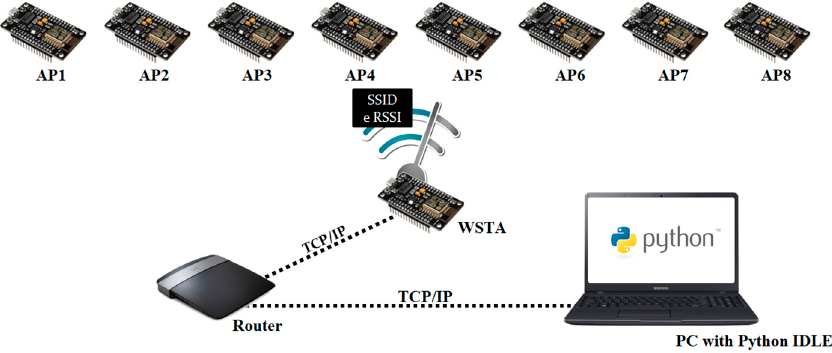
Figure 2. Connection diagram of the elements that make up the localization system.